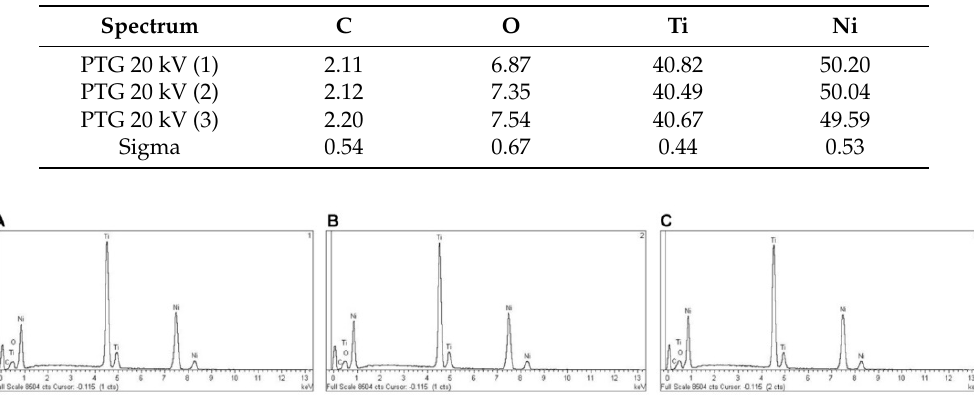
Table 7. Mean atomic weight percent (%) of CM-Gold Wire alloy PTG endodontic rotary files at 15 kV and 20 kV at three different locations (1, 2 and 3).